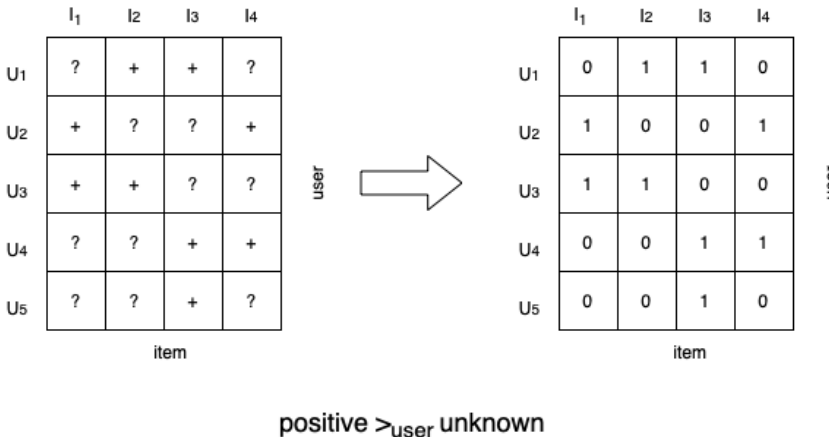
Figure 1. Generation of negative samples for items the user did not interact with [25].